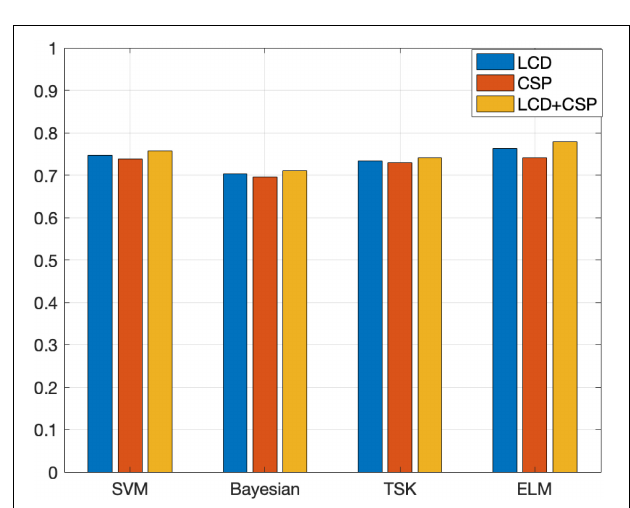
FIGURE 7 | Kappa coefficient obtained by each classification model on the Data Sets